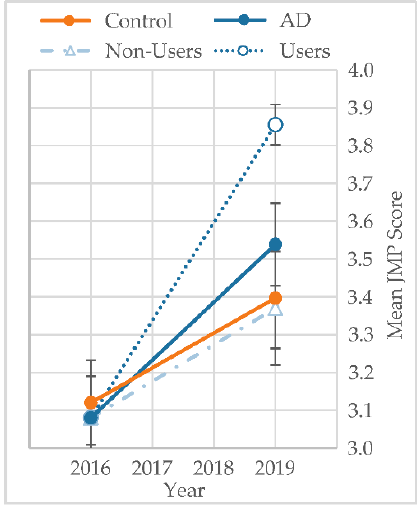
Figure 6. Mean JMP service level scores from 2016 to 2019.